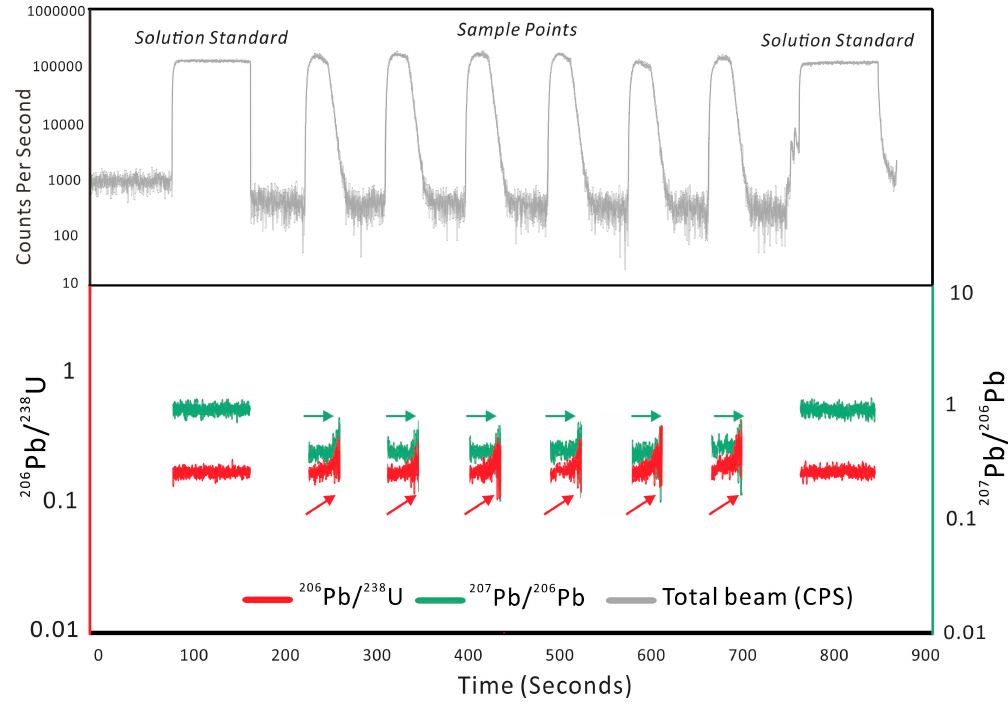
Figure 7. Time-resolved spectra data produced using IOLITE from data obtained from hematite in Olympic Cu-Au Province samples. Note no downhole fractionation within the solution standard, but significant fractionation of the 206 Pb/ 238 U ratio (red), which increases with time during the duration of the spot analysis. The 207 Pb/ 206 Pb ratio (green) remains relatively constant throughout analysis, showing the robustness of the 207 Pb/ 206 Pb ages. This represents a minor disadvantage of the method but may be overcome in the future through linear rastering rather than spot analysis, if the homogeneity of the analyzed grain allows this.